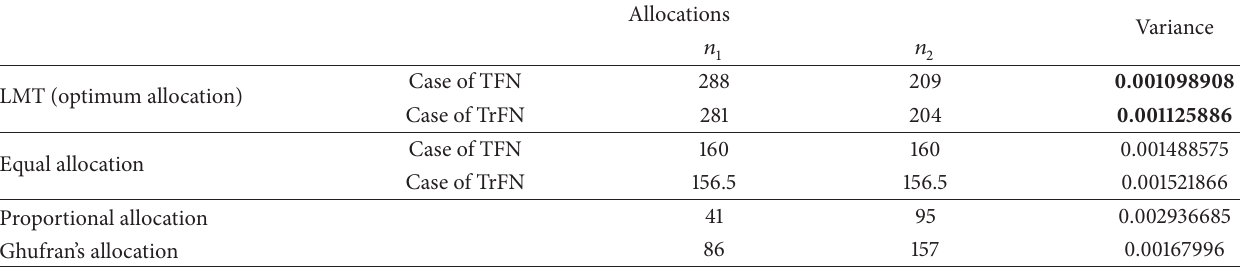
Table 3: Optimum